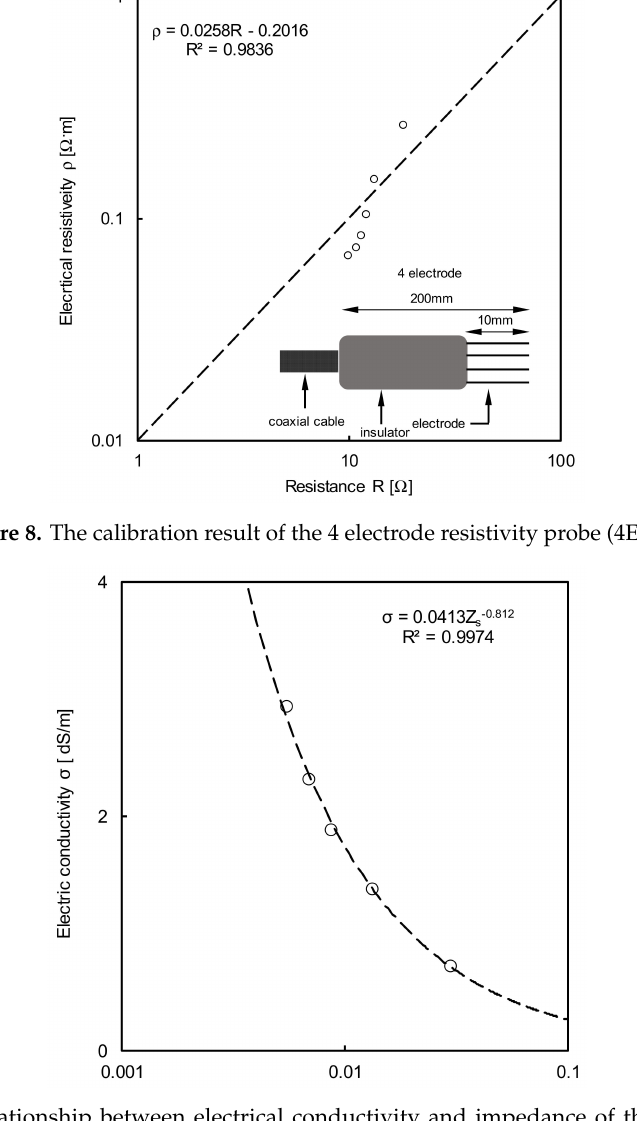
Figure 9. The relationship between electrical conductivity and impedance of the soil sample for obtaining cell constant. The cell constant is deduced as 0.0413 in this